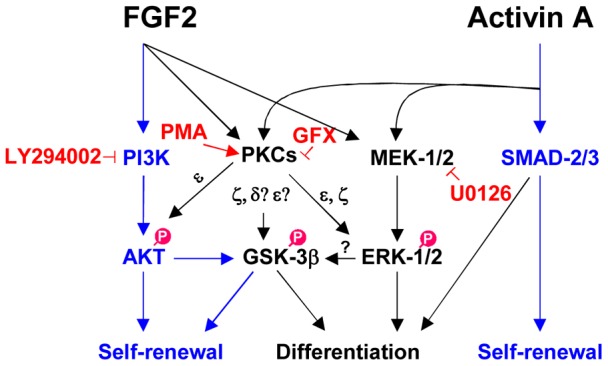
Model for the molecular mechanism of PKCs regulating self-renewal or differentiation in hPS cells.Our study suggested a model that FGF-2 activates PI3K/AKT, MEK/ERK-1/2, and PKCε/δ/ζ. PKCε, δ, and ζ inactivates directly or indirectly GSK-3β by phosphorylation which promotes differentiation of hPS cells. PKCε and ζ activates ERK-1/2 which promotes differentiation of hPS cells. Activin A activates SMAD-2/3 which controls self-renewal and differentiation while activin A together with FGF-2 activates both ERK-1/2 and PKCs. Inhibition of both ERK-1/2 and PKCs pathway provides a metastable undifferentiated state of hPS cells. Blue arrow indicated pathway promoting hPS cell self-renewal and black arrow indicated pathway promoting hPS cell differentiation.